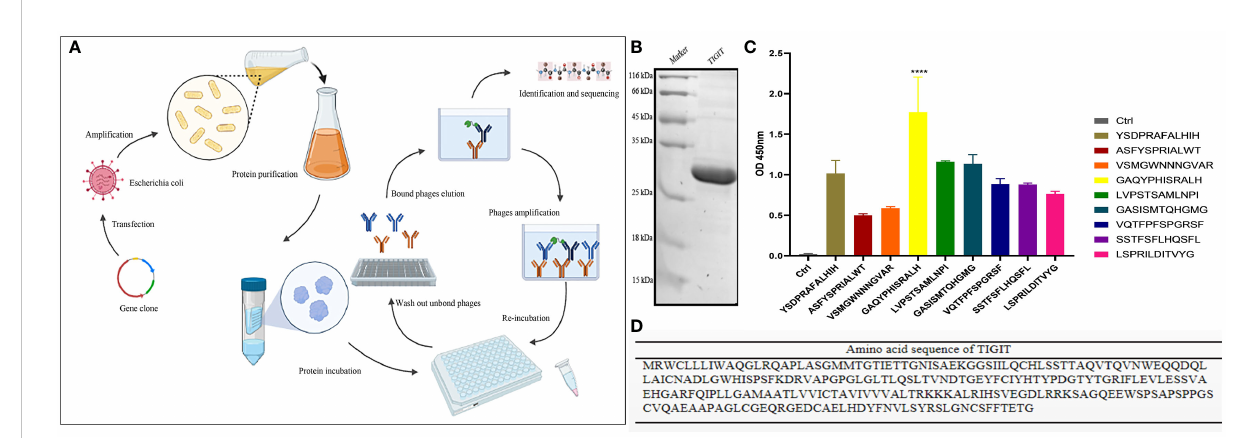
FIGURE 3 Identi fi cation of TIGIT-targeted peptides. (A) A fl ow chart for screening of TIGIT-targeted peptide. (B) Amino acid sequence of TIGIT protein. (C) Coomassie Brilliant Blue staining of TIGIT protein after puri fi cation. (D) The binding af fi nities of selected nine peptide. The OD values were analyzed by phage ELISA. **** P <